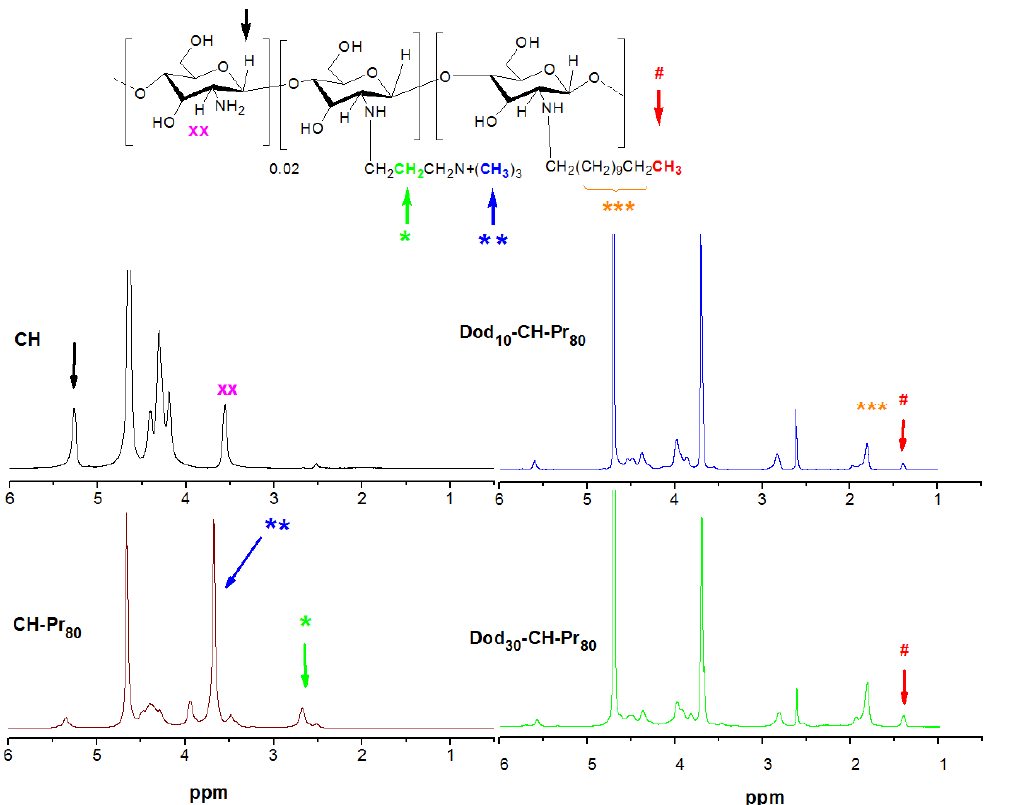
Figure 1. 1 H-NMR spectra of deacetylated chitosan ( CH ), quaternary derivative ( CH-Pr and its amphiphilic derivatives ( Dod (green color) were used to determine DS (red color) of Dod groups were used to determine DS D O/DCl (1%). 2